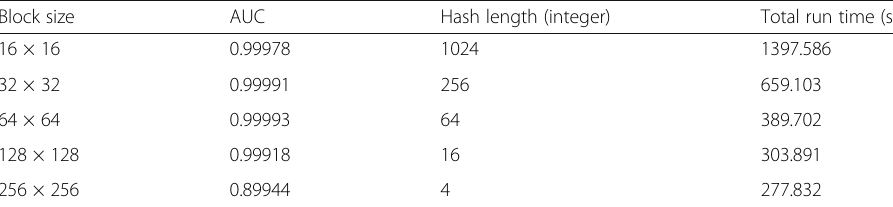
Table 4 Our performances under different block sizes